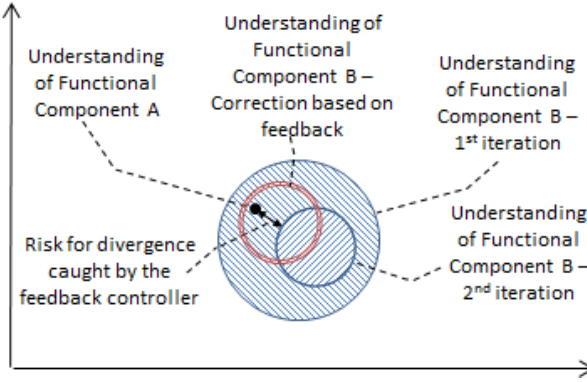
Figure 3. Interpretation space and the work of the feedback controller